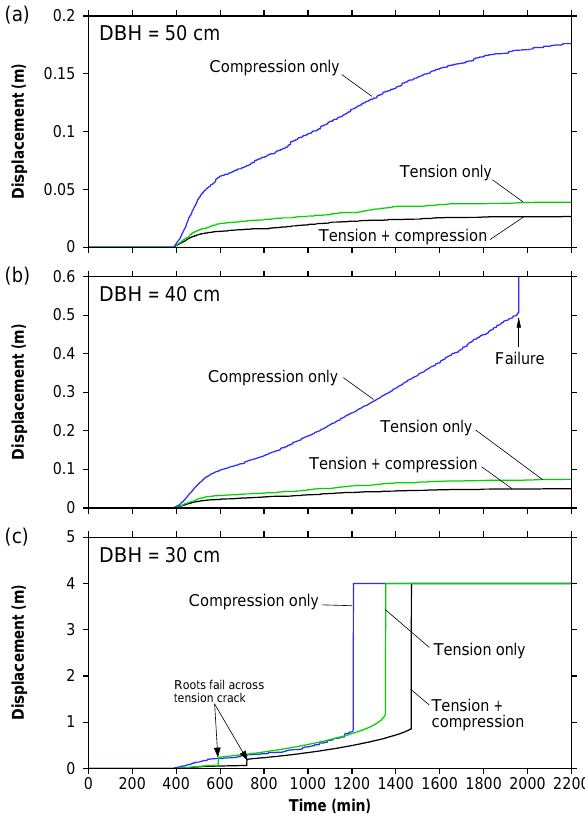
Figure 10. Effects of tensile and compressive strength of roots on slope displacement and stability for trees of different diameters. Displacement at the slope center ( x = y = 0) as a function of time for (a) a stand of trees 50cm in diameter, (b) 40cm in diameter, and (c) 30cm in diameter. Trees are spaced 3m apart in each cases. Each graph shows three curves for roots with both compressive and tensile strength, roots with only tensile strength, and roots with only compressive